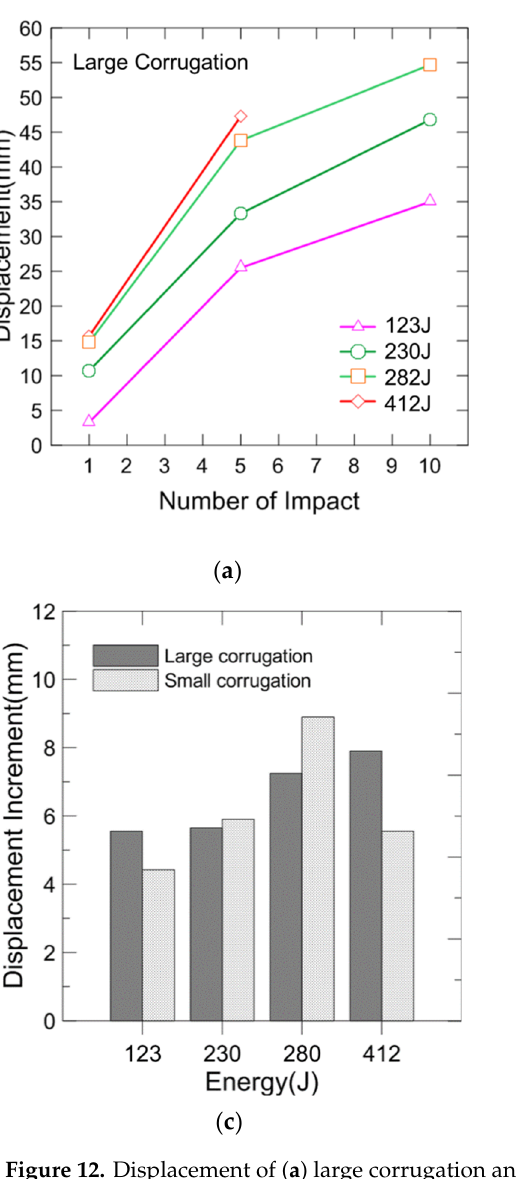
Figure 13. Collapse phase of corrugation under the repeated impact loading. In the case of the smallest corrugation specimens, as the impact energy increases, the displacement increment also increases. However, the displacement increment of a small corrugation in the S412 scenario suddenly decreases. The displacement increment per number of impacts in the S123 scenario from the sixth to tenth impact is less than from the first to fifth impact because of the collapse phase of the corrugation under the lateral impact. A small corrugation specimen in the S282 and S412 scenarios is completely collapsed under the third impact, whereas a